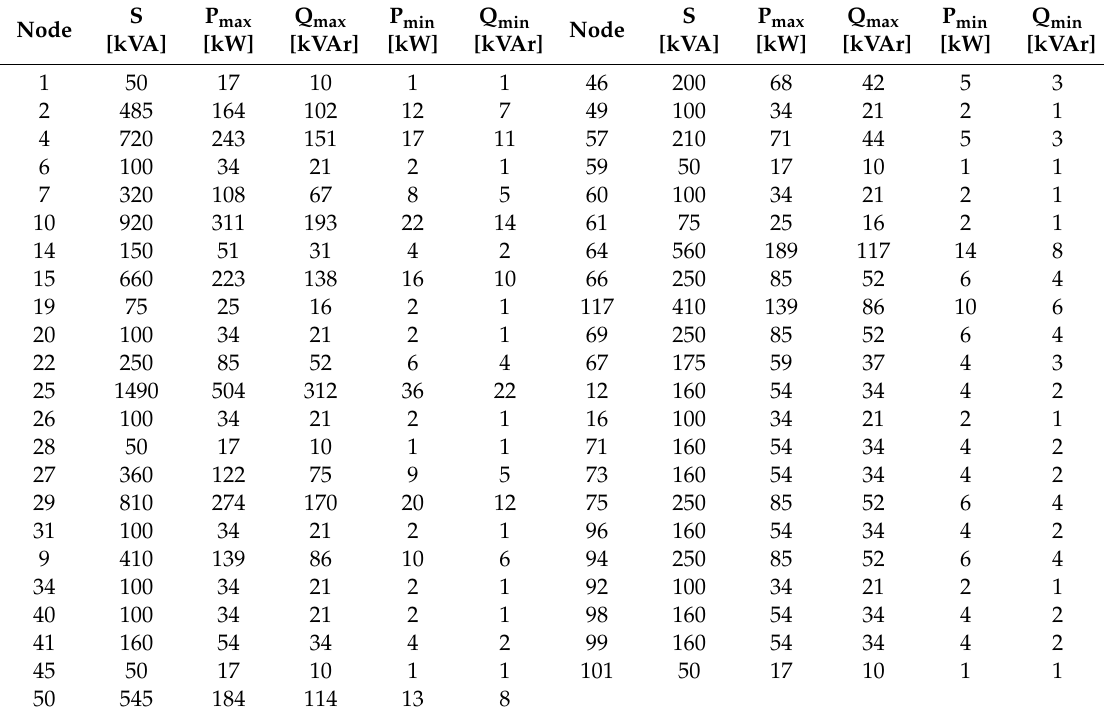
Table 2. Installed capacity (S), maximum and minimum active and reactive loads (P max , Q max , P min , Q min ) of each 20 / 0.4kV distribution transformer.